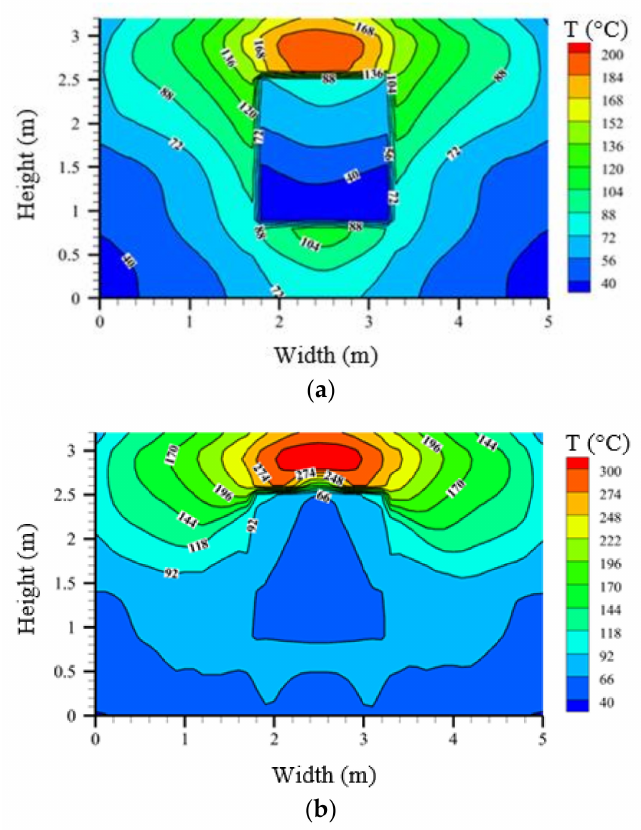
Figure 19. Temperature field of glass surface under window sprinkler conditions: ( a ) 50 s, ( b ) 150 s.